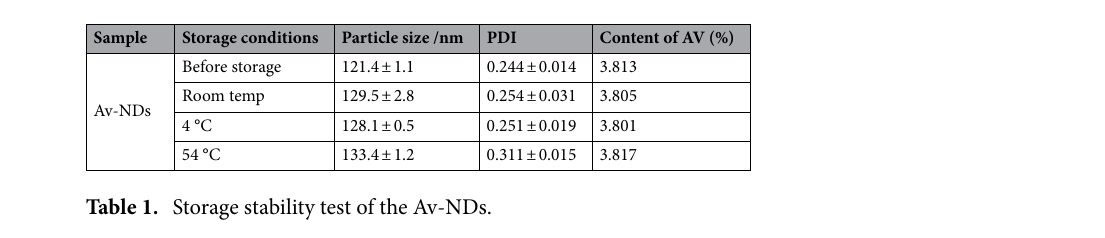
Figure 7. 1 H NMR of the cross-linked sodium lignosulfonate (c-SL) and the sodium lignosulfonate (SL) (The preparation method of c-SL is identical with that of Av-NDs, but avermectin was not added during the preparation process).